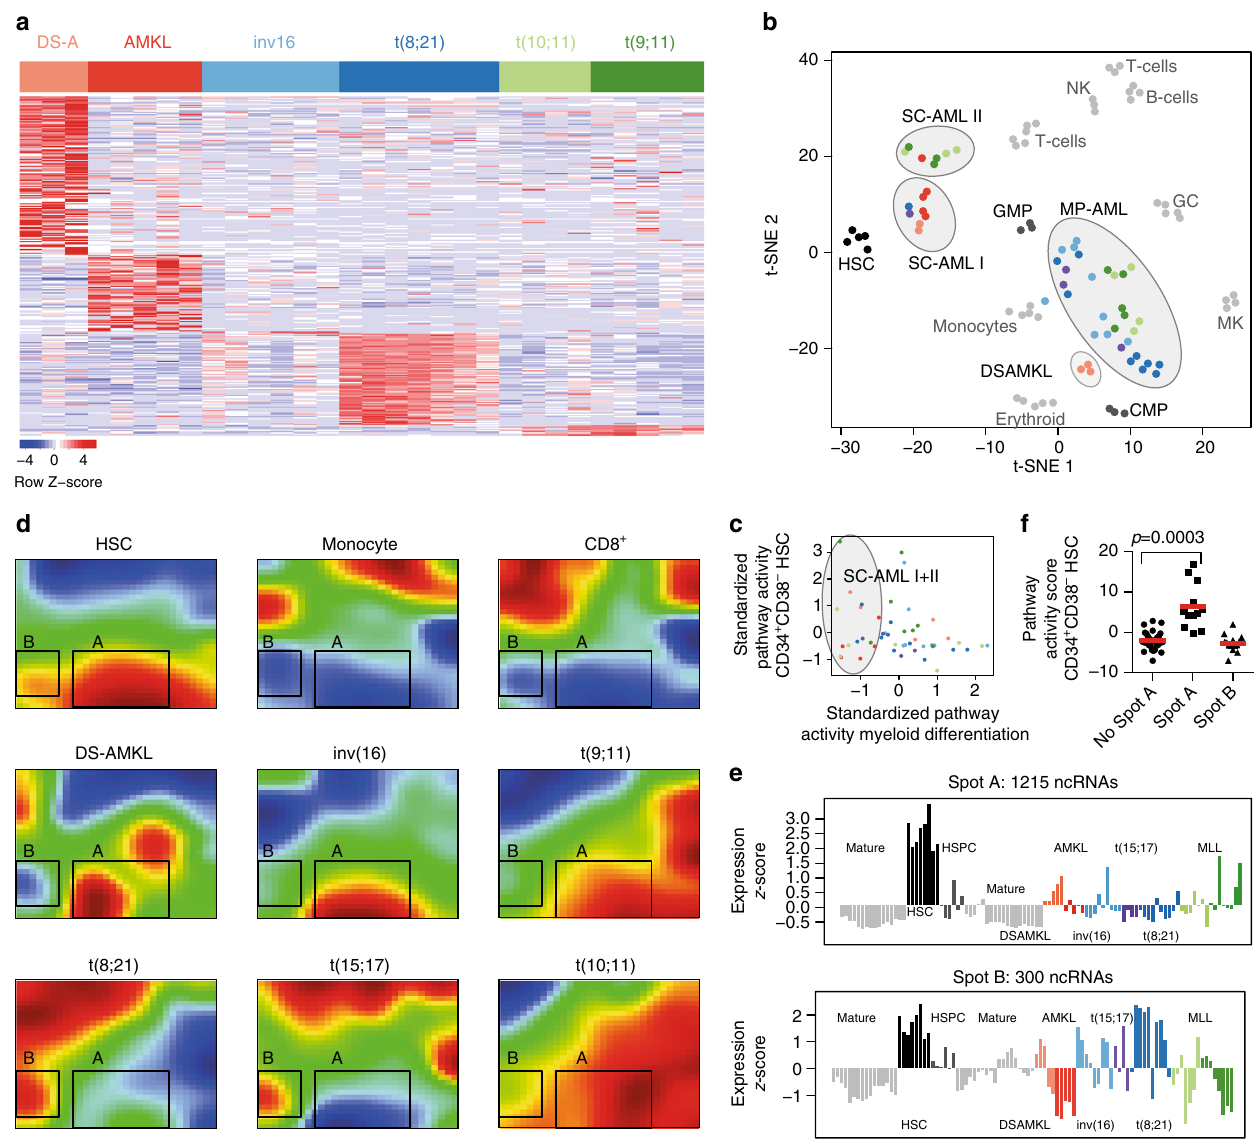
Fig. 6 Integrated analysis reveals ncRNA stem cell signature in AML and HSCs. a Heatmap of pediatric AML subtype-speci fi c fi ngerprint ncRNAs. b Two-dimensional t -SNE plot using 1877 variance- fi ltered ncRNAs. The clusters were called by densVM and correspond to 11 healthy populations and 4 AML clusters. c Standardized pathway activity scores 34 of the myeloid ( x -axis) vs. HSC-speci fi c expression program ( y -axis) as de fi ned by our resource. Samples belonging to the SC-AML I and II clusters are indicated by gray ellipses. d SOM-expression portraits obtained using 7094 variance- fi ltered ncRNAs as input. Shown are three healthy cell populations ( top ) including HSCs ( top left ) — which are characterized by high expression of Spot A and B metagenes (corresponding to 1215 and 300 ncRNAs, respectively) — and AML samples displaying high expression of Spot A or Spot B metagenes. All samples are shown in Supplementary Fig. 9. e Expression pro fi les of Spot A metagenes (above) and Spot B metagenes (below) across all samples. f Pathway activity scores 34 for the HSC-speci fi c expression programs in “ Spot A ” and “ Spot B ” AMLs. P -value was calculated using the